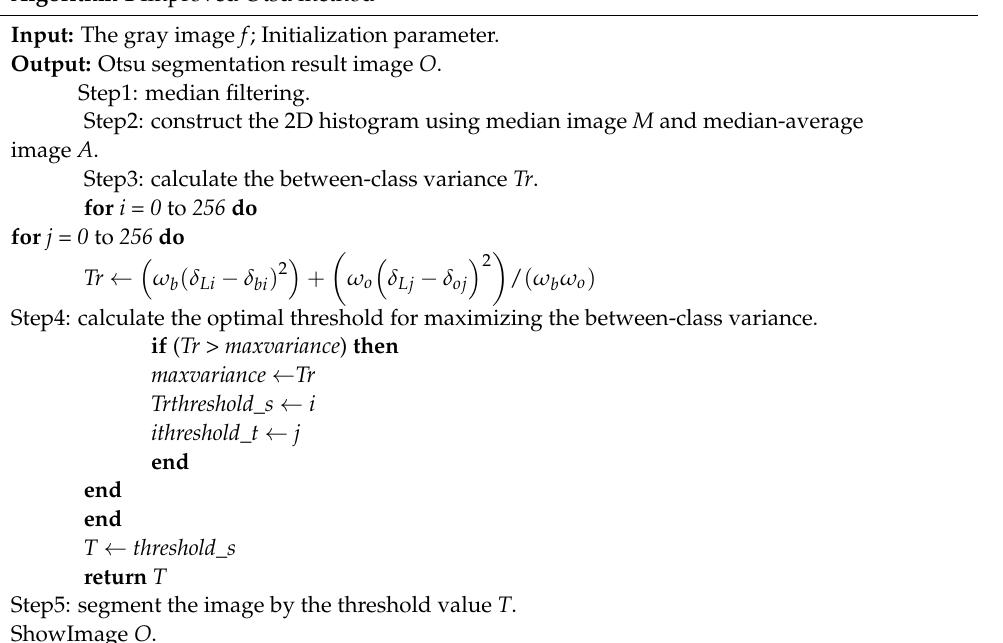
Algorithm 1 Improved Otsu